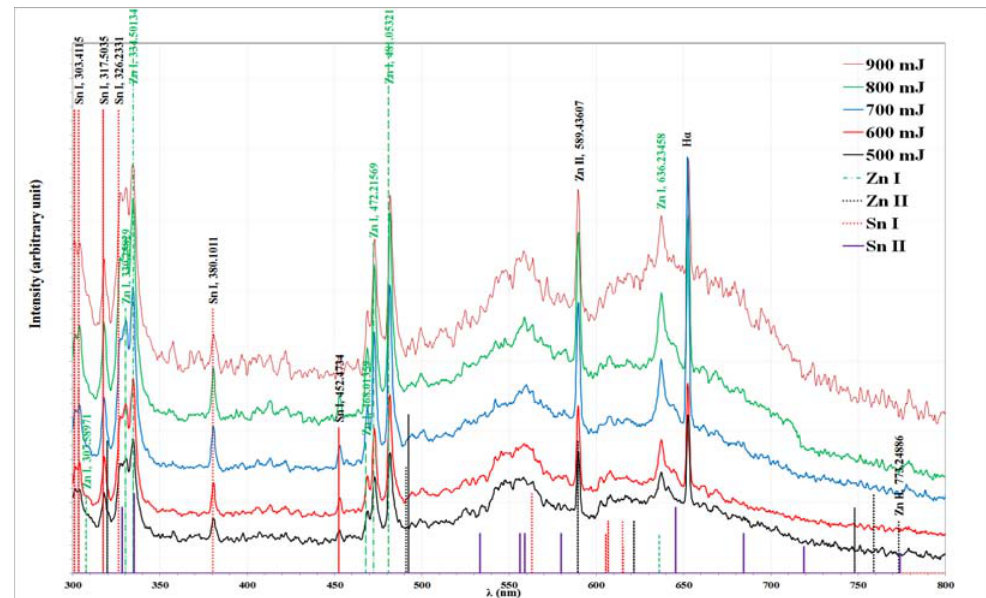
Fig.2 (b): Spectroscopic patterns for plasma emission from X= 0.4 SnO different laser energy.